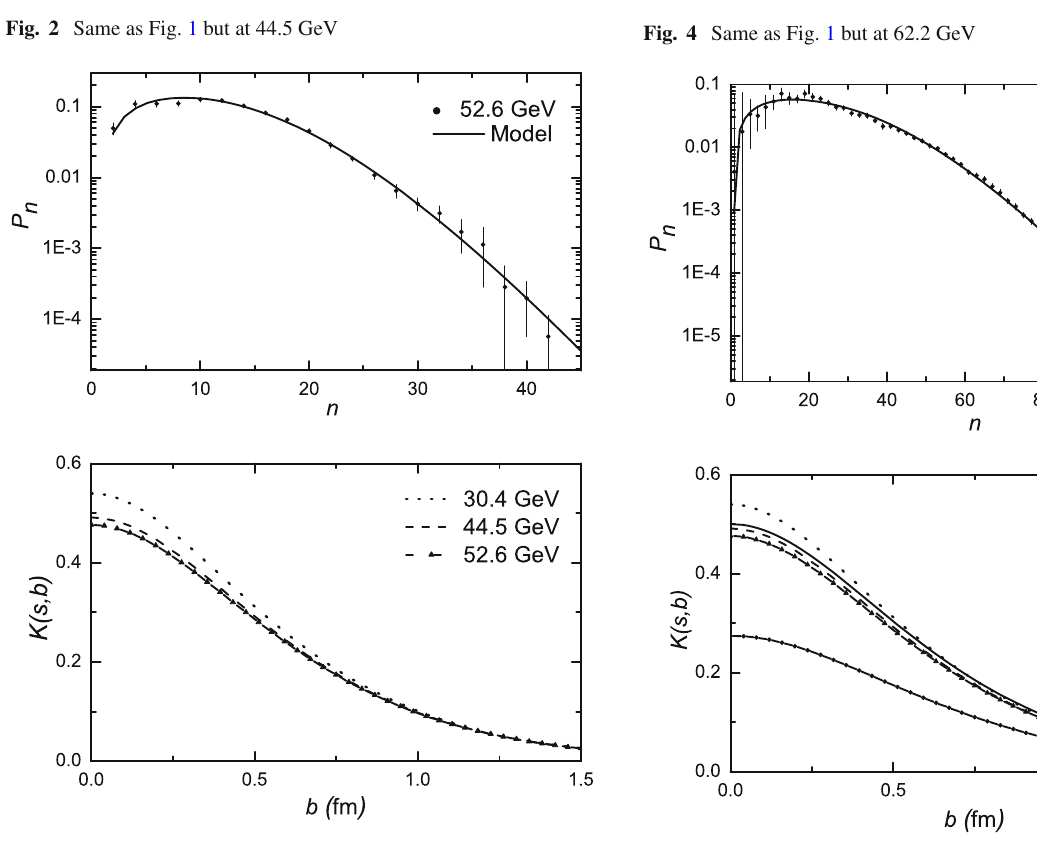
Fig. 3 Same as Fig. 1 but at 52.6 GeV